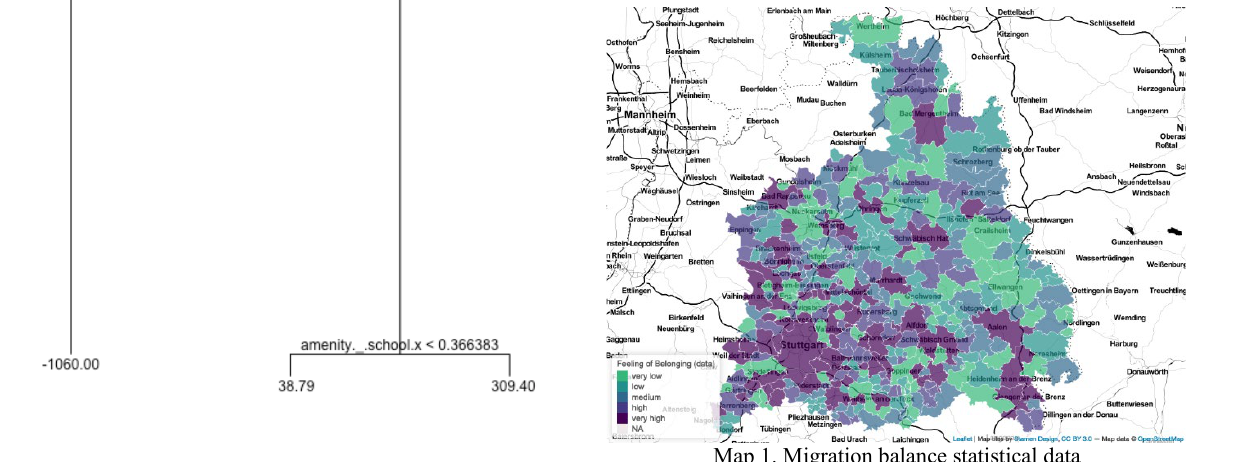
Figure 1. Regression tree feeling of belonging to community The tree has only one further node with the tag amenity school.